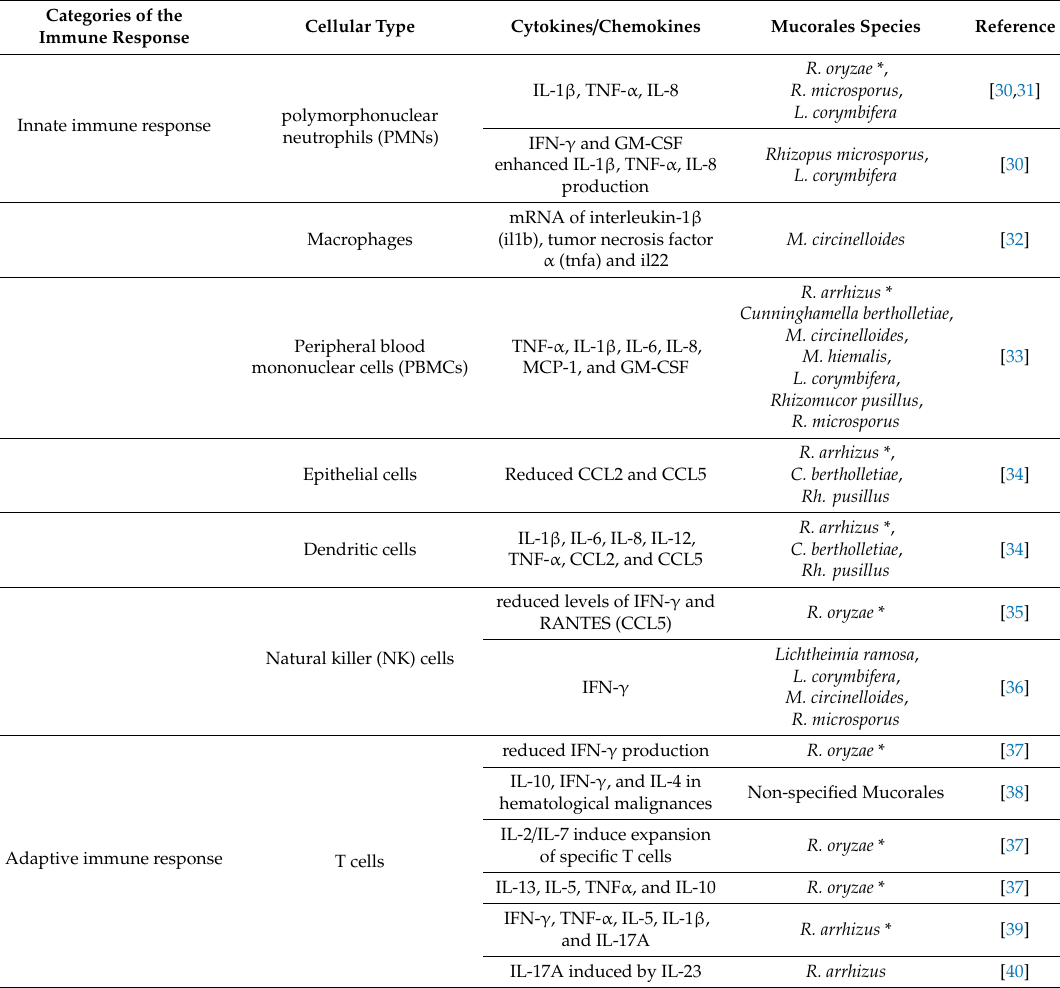
Table 1. Cytokine and chemokine production in response to pathogenic mucoralean species—an overview of current